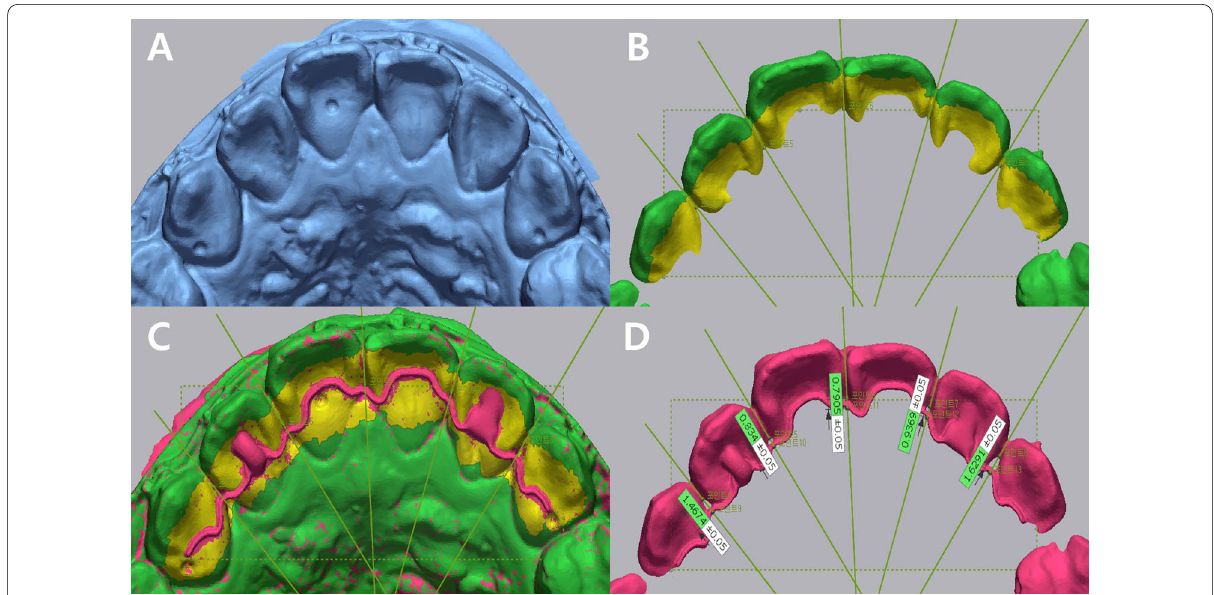
Fig. 4 Measurement of WCI. A Initial scan model with three dimples. B Setting of reference plane (dotted line), five interproximal surfaces (solid line) and five reference points. Yellow area indicates the part excluded when superimposing. C After superimposition between the initial scan model and the model with the retainer attached. D Length measurement between two points in five interproximal areas